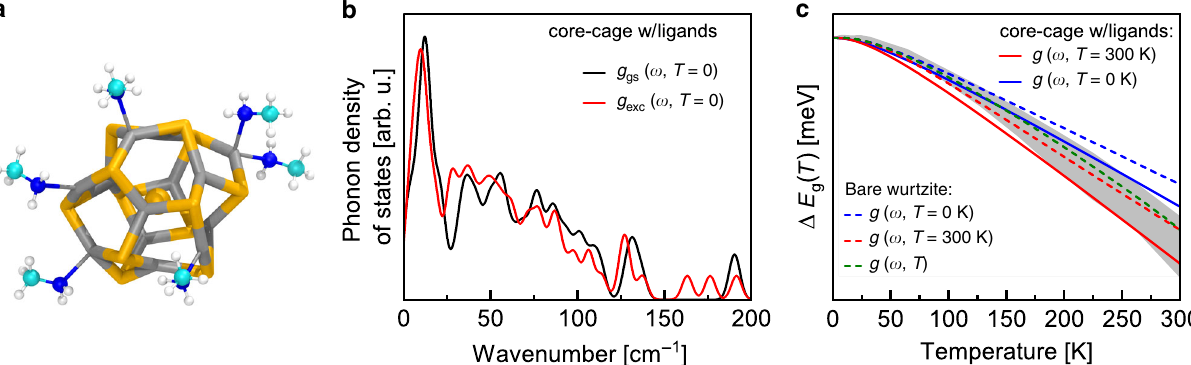
Fig. 3 Calculated phonon density of states (PDOS) and bandgap relaxation with temperature. a Relaxed structural model of a core/cage (CdSe) 13 magic sized cluster (MSC) with methylamine (MA) ligands in the ground state electronic con fi guration. b Normalized PDOS for core/cage (CdSe) 13 MSC as shown in a in the ground and HOMO → LUMO + 1 excited state electronic con fi gurations, respectively, used to calculate Δ E g ( T , g corecage ( ω , T = 0 K)) (blue straight line in c ). Note, that beside the modes inherent to the CdSe cluster, the PDOS also contains vibrational and rotational modes stemming from the MA ligands. c Temperature-dependent bandgap shift of (CdSe) 13 MSCs calculated using phonon frequencies obtained in harmonic approximation g ( ω , T = 0 K)) (blue), including anharmonicities g ( ω , T = 300 K) (red) and with full temperature dependence g ( ω , T) (green), in comparison to experiment (grey area). Solid and dashed lines denote the core/cage MSC with MA ligands and the sliced-wurtzite MSC without ligands, respectively.